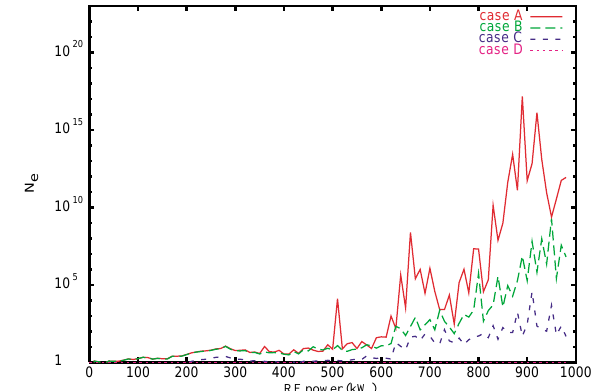
FIG. 5. (Color) Simulated N e as a function of rf input power for material configurations defined earlier, for trajectories starting inside the cavity.